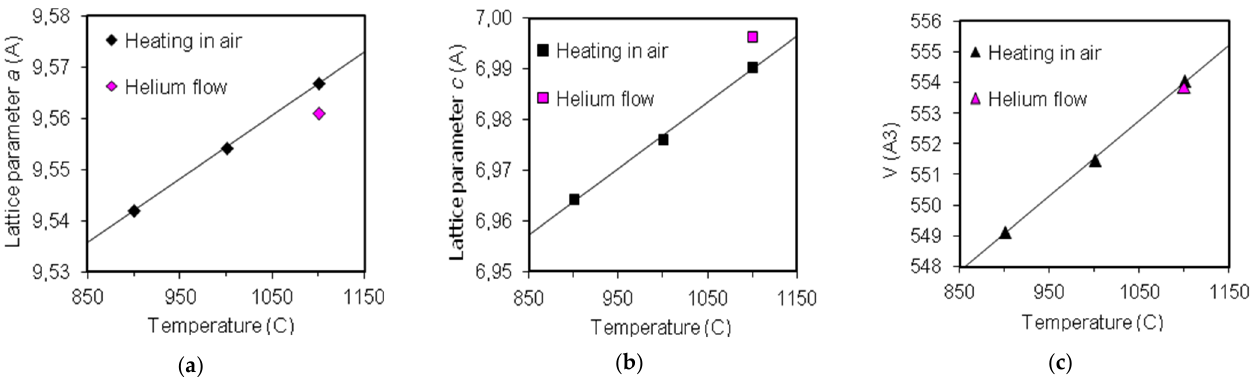
Figure 5. In situ PXRD patterns of the HA pellets heated at different temperatures in air and in helium flow; ( a )—general view, ( b )—enlarged view of the 49.4–53 o 2θ region.